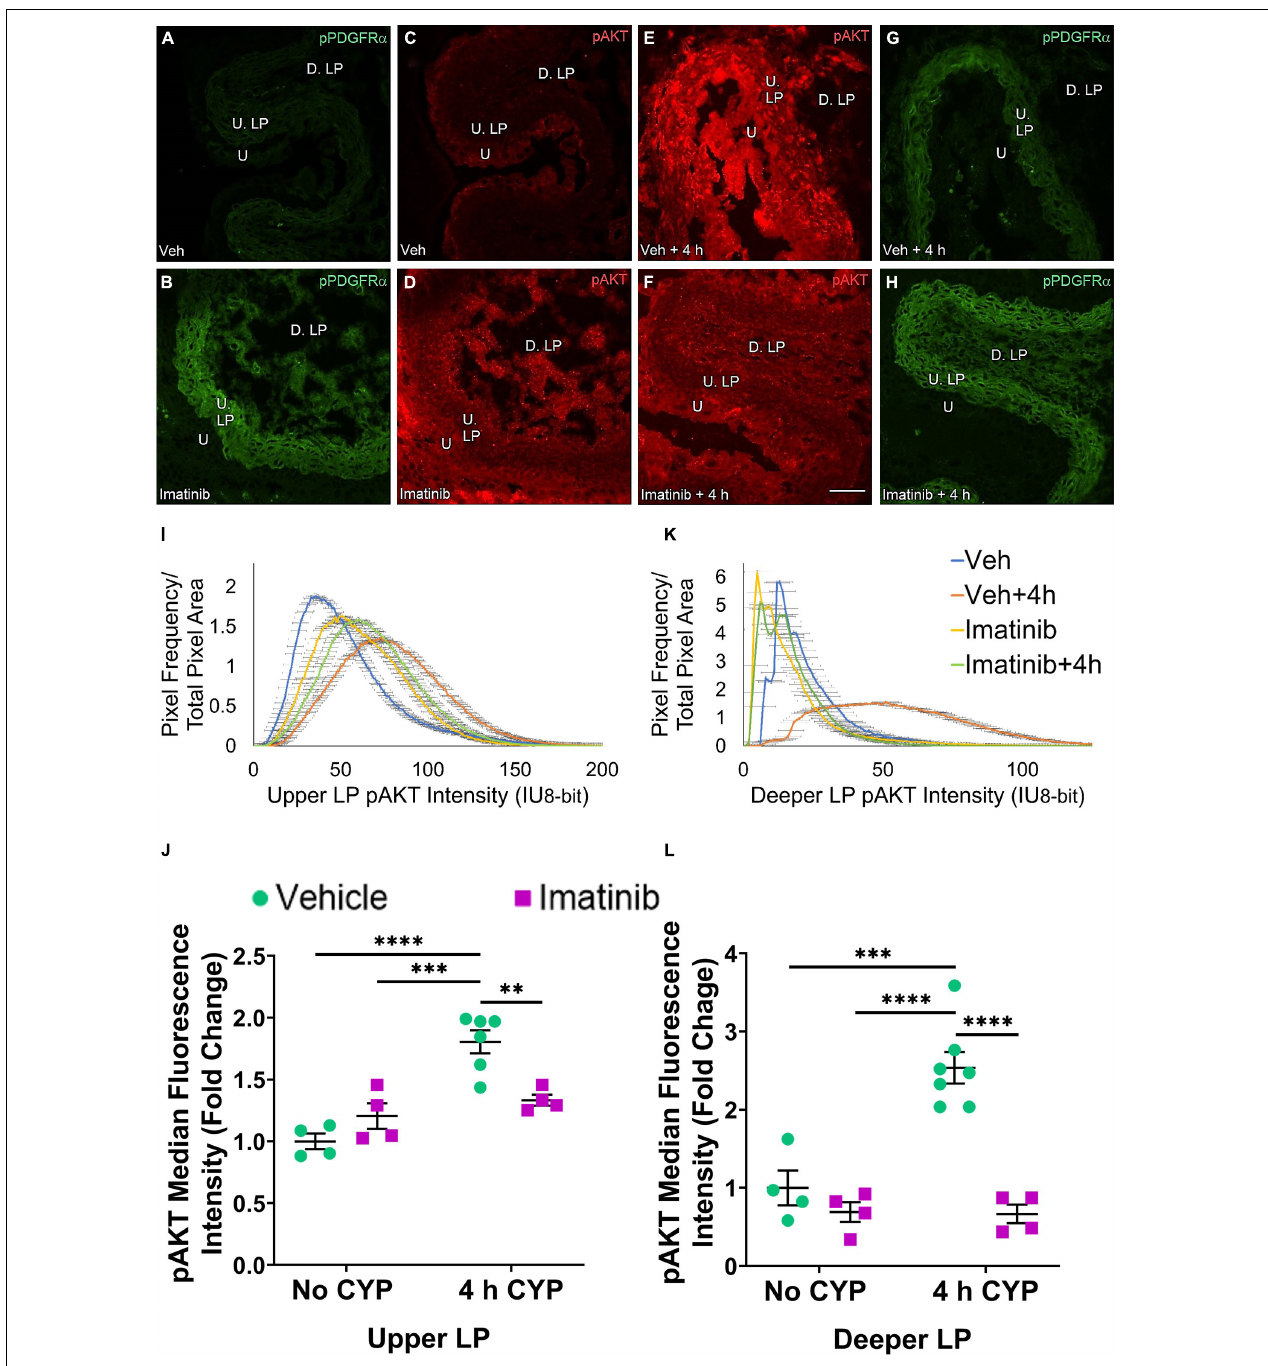
FIGURE 10 | Transurethral bladder infusion of imatinib mesylate reduces pAKT expression in the upper LP (U. LP) and deeper lamina propria (D. LP), in an acute (4 h) cyclophosphamide (CYP)-induced cystitis female mouse model. Representative (A–H) images, (I) upper LP and (K) deeper LP fluorescence intensity curves of pAKT immunoreactivity (CY3, red) in the urinary bladder (10 µ m sections) in female mice with (E) acute (4 h) cyclophosphamide (CYP)-induced cystitis (200 mg/kg, i.p.) and (C,D) controls (no CYP), (F) treated with imatinib mesylate via transurethral intravesical infusion (50 µ M, 30 min). (A,B,G,H) Bladder tissue was co-stained for pPDGFR α (FITC, green), and the corresponding images are displayed to provide orientation. 4 h CYP treatment significantly (0.0001 ≤ p ≤ 0.001) increased pAKT expression in the (J) U. LP (1.8-fold) and the (L) D. LP (2.5-fold), compared to vehicle controls. Imatinib treatment significantly (0.0001 ≤ p ≤ 0.01) reduced pAKT expression in the (J) U. LP (1.4-fold) and the (L) D. LP (3.8-fold) in female mice with 4 h CYP-induced cystitis. Raw IHC values (intensity units, 8-bit) were converted to and are displayed as fold change values ± SEM with respect to the control group (vehicle, no CYP). n = 4–7. * p ≤ 0.05; ** p ≤ 0.01; *** p ≤ 0.001; **** p ≤ 0.0001 by two-way ANOVA with Tukey’s multiple comparisons test. Tissues were processed simultaneously. Microscope and camera settings were kept constant across all groups. Fluorescence intensity was measured using Volumetry image analysis software (VolumetryG9a, Grant Hennig). Scale bar = 50 µ m. U, urothelium; U. LP, upper lamina propria; D. LP, deeper lamina propria; IU, intensity units.